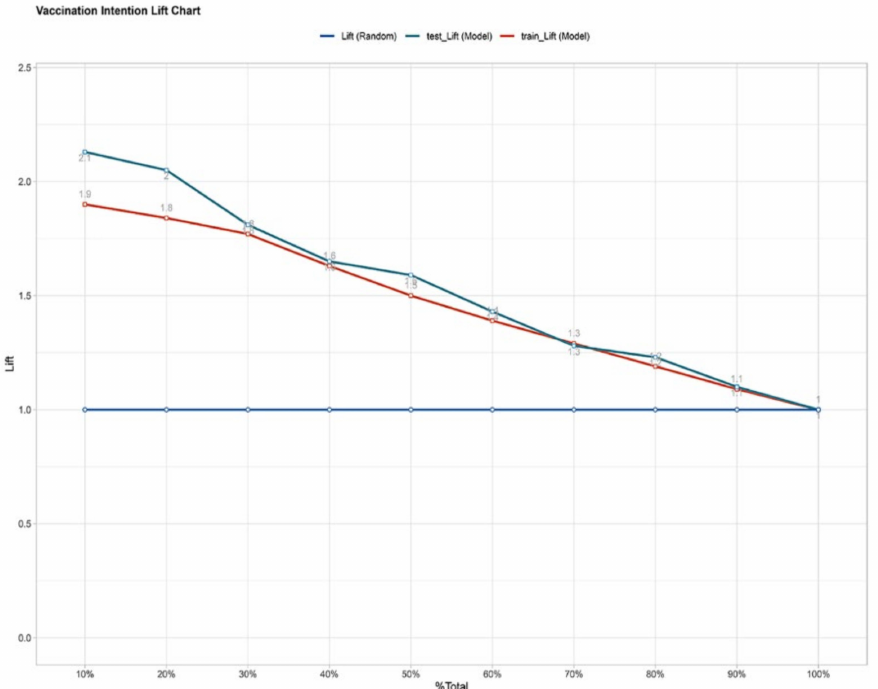
Figure 5. The lift chart in the training set and test set. The lift chart of the vaccination intention prediction model. The bule line is random, the red line represents the performance of the model in the training set, and the green line represents the performance of the model in the test